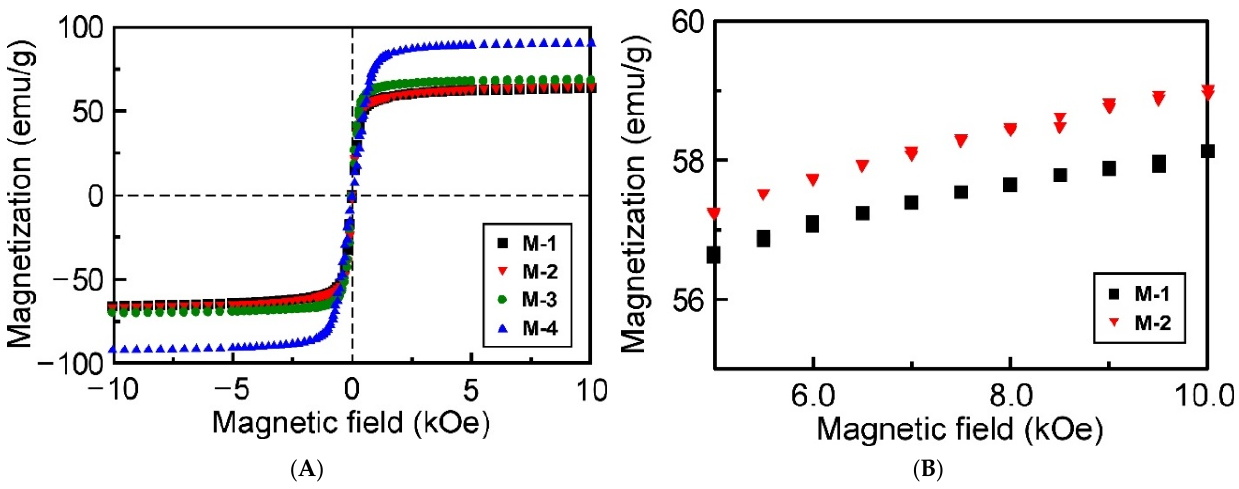
Figure 3. ( A ) Magnetic hysteresis loops of magnetite microparticles measured at 27 °C. ( B ) An enlarged profiles of M-1 and M-2 in the range of 5 kOe to 10 kOe for comparison of their magnetization difference.